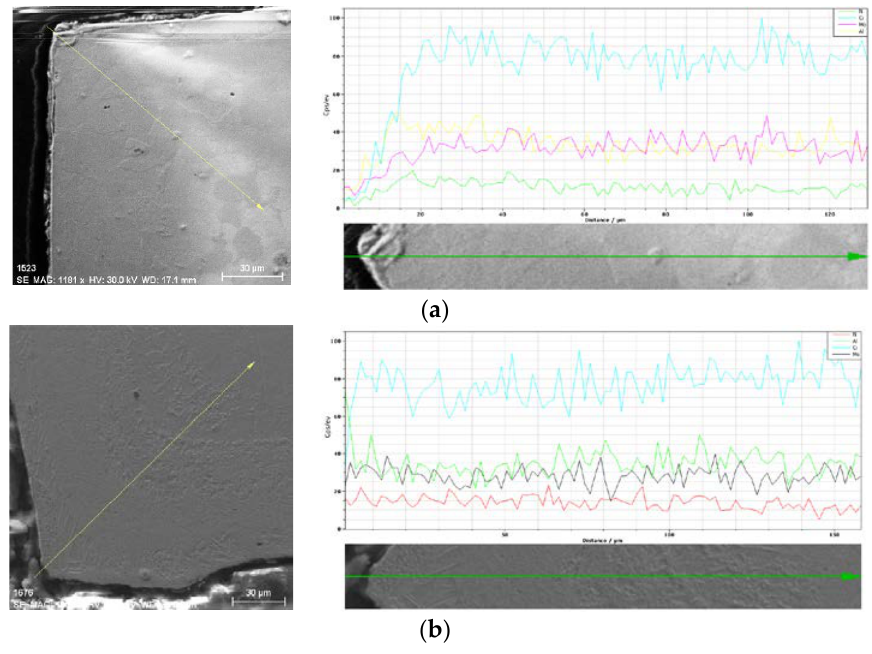
Figure 11. Chemical element distribution for N, Al, Cr, and Mo, and line analysis, for 90° area, after plasma nitriding: ( a ) no screen and ( b ) with a polarized screen.